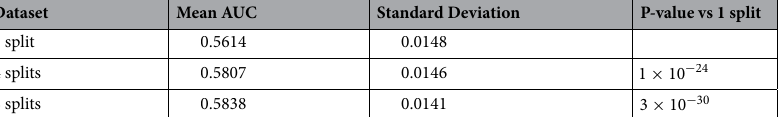
Table 1. The mean and standard deviation of the cross validated AUCs of 1 split, 4 splits, and 8 splits datasets of 150 models each.